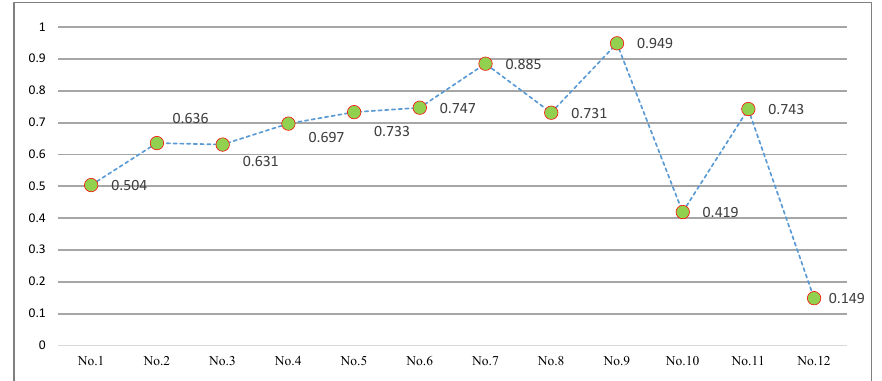
Technological distance measurement. According to the minimum complementary distance measure, the distance between ESL and 12 firms is shown in Figure 9.